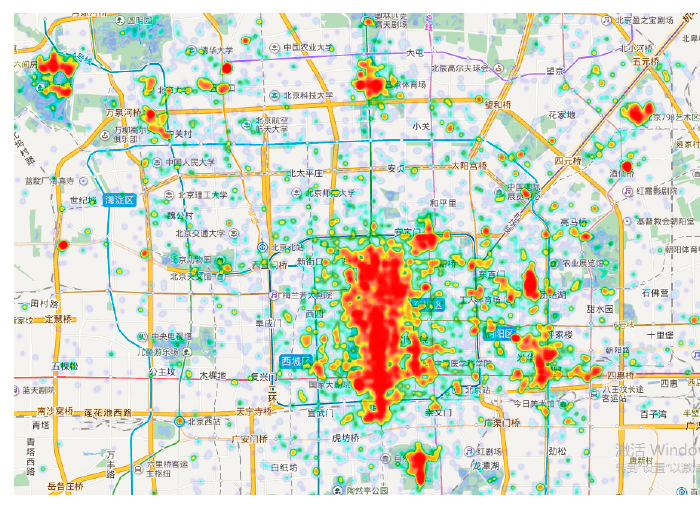
Figure 5. Heat map of tourist attraction-visiting activities.